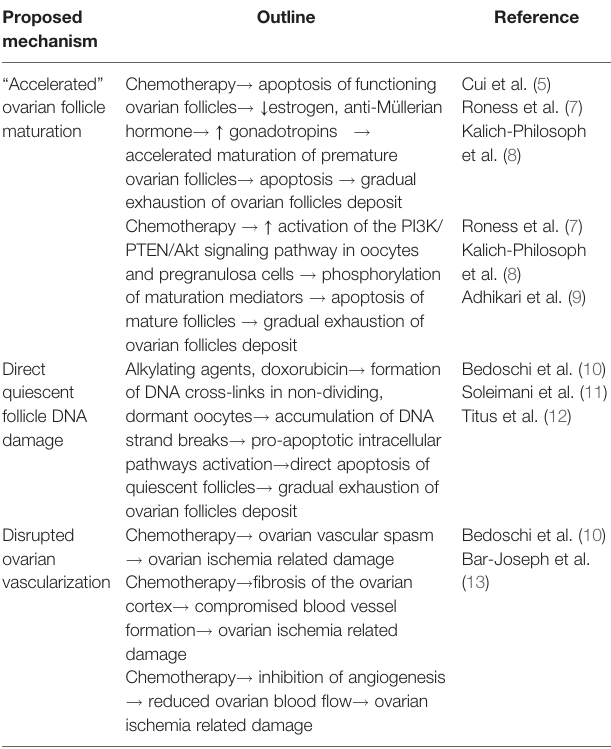
TABLE 2 | Summary of the suggested underlying mechanisms by which chemotherapy compromises follicular ovarian reserve (5, 7 –